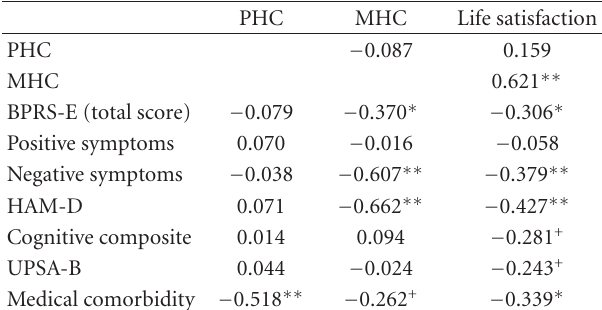
Table 3: Summary of bivariate correlations among quality of life indicators and psychiatric symptoms, cognition, functional capacity, and medical